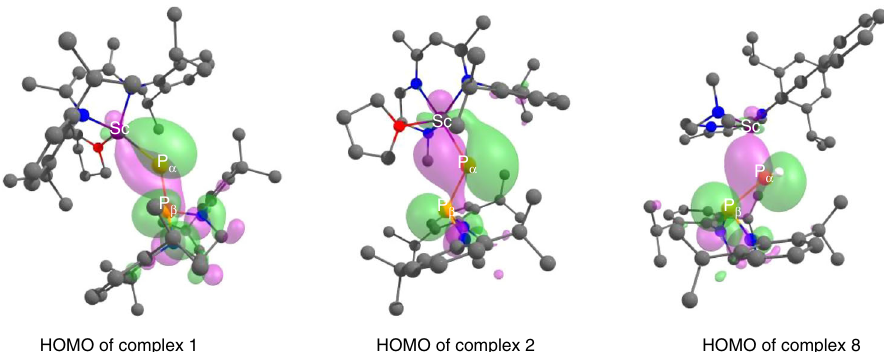
Fig. 5 HOMO of complexes 1, 2, and 8. The HOMO presents a donor – acceptor interaction between the lone pair on P β and Sc. Atom color code: purple, scandium; orange, phosphorus; red, oxygen; blue, nitrogen; gray, carbon; and